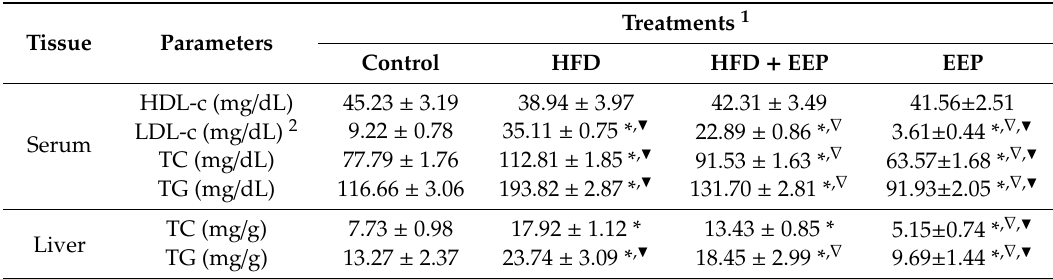
Table 4. E ff ects of ethanol extract of propolis on serum compounds, liver triglycerides, and cholesterol in high-fat diet fed mice.